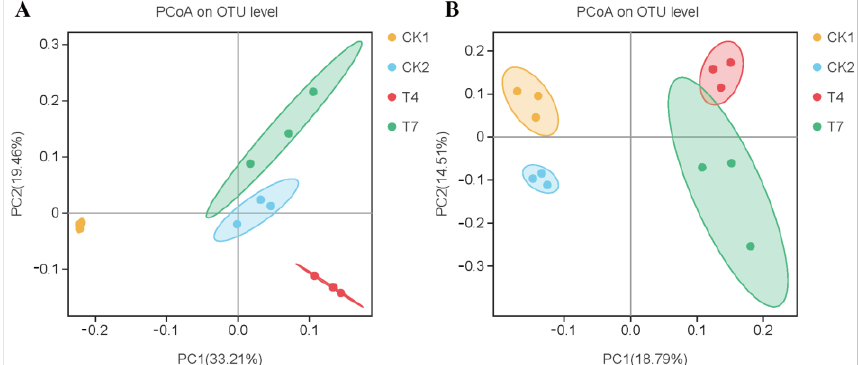
9 of 25 Figure 2. Effect of different composting treatments on the α -diversity of soil microbial communities. ( A ) α -diversity of the bacterial communities in rhizosphere soil. ( B ) α -diversity of the fungal com- munities in rhizosphere soil. 3.5. Effect of Different Composting Treatments on Beta Diversity of Bacterial and Fungal Communities in Soils The PCoA analysis showed that the different composting treatments altered the com- munity composition of soil bacteria and fungi (Figure 3). For the bacterial community structure, the first and second principal coordinates explained 33.21% and 19.46% of the differences among the five treatments, respectively (Figure 3A). The bacterial communi- ties of the CK2, T4, and T7 treatments were significantly separated from those of the CK1